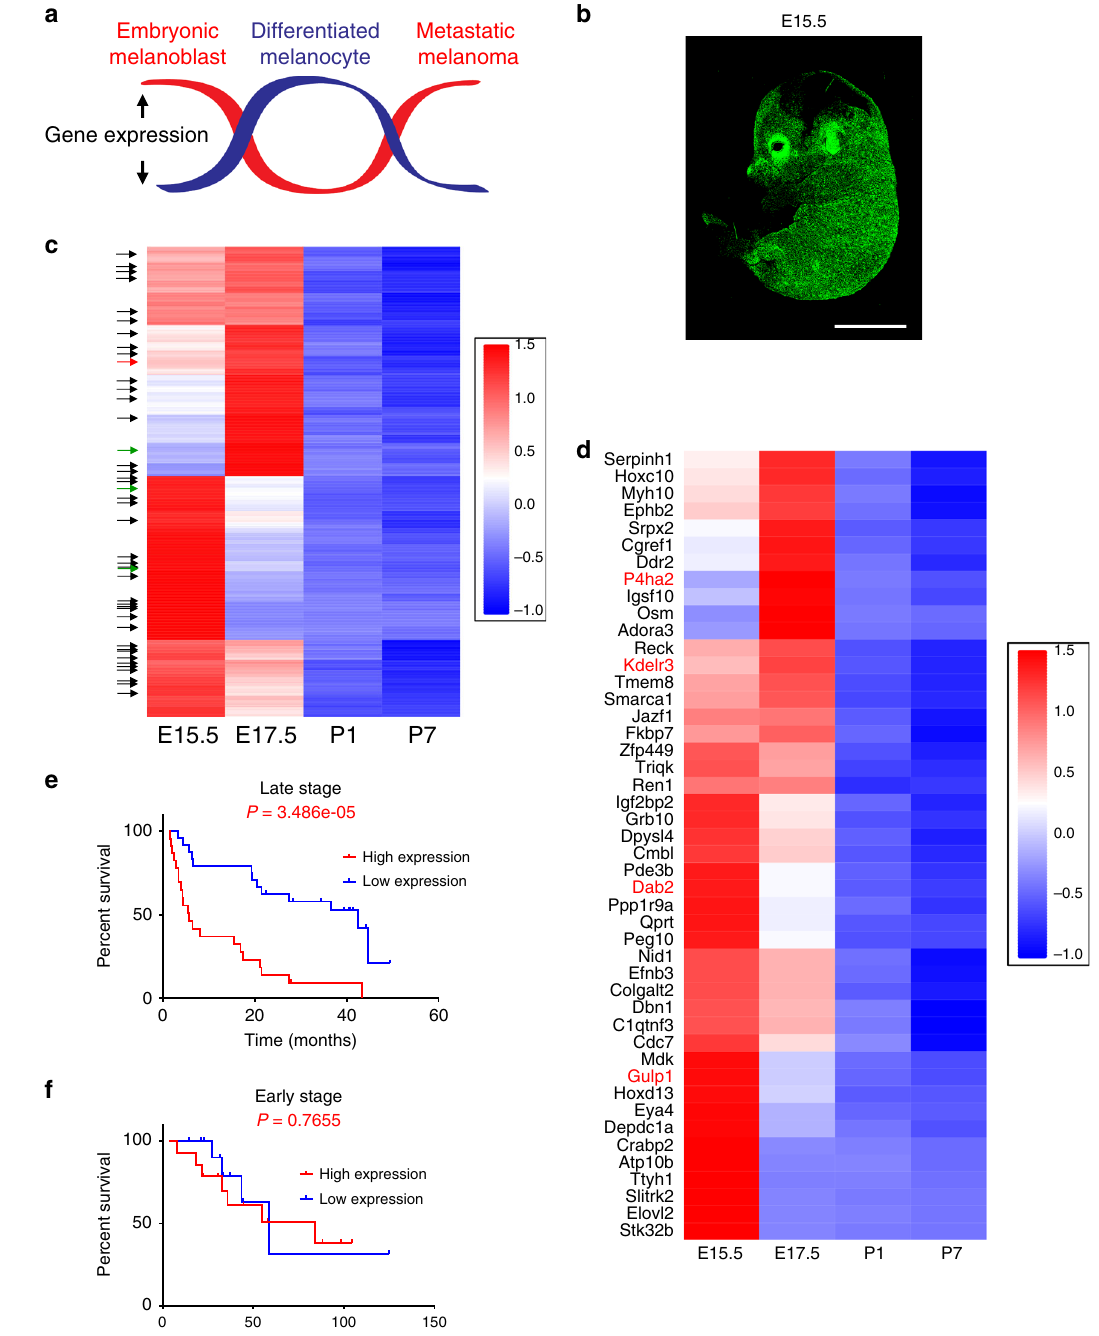
Fig. 1 Discovery of metastasis development (MetDev) genes. a Schematic depicting the experimental hypothesis: genes whose expression is upregulated in melanoblasts and metastatic melanoma, but downregulated in differentiated melanocytes (red line), may drive cellular functions that promote melanoma metastasis (MetDev genes). b Confocal imaging of i Dct-GFP embryo at embryonic day 15.5 (E15.5) is magni fi cation ×5, scale bars, 5 mm. c RNA-seq expression of mouse developing melanocytes: 467 embryo-speci fi c genes shown. Black arrows: 42 genes identi fi ed from Cox proportional hazards model. Green arrows: genes functionally validated. Red arrow: Kdelr3 . Kdelr3 validated both in Cox proportional hazards model and functionally validated. Embryonic days 15.5 and 17.5 (E15.5 and E17.5, respectively). Postnatal day 1 and postnatal day 7 (P1, P7, respectively). d RNA-seq expression of 46 genes in mouse developing melanocytes: Black text: 42 genes identi fi ed from Cox proportional hazards model. Red text: four genes functionally validated. Kdelr3 validated both in Cox proportional hazards model and functionally validated. e , f Cox proportional hazards modeling (GSE19234) yielded a 43-gene MetDev signature. Patients ’ risk assessed in GSE8401 patient cohort. Late stage: stage III/IV metastatic melanomas. Early stage: stage I/II primary tumors. High expression: high expression of gene signature. Low expression: low expression of gene signature. Log-rank test. Late stage, high ( N = 23) vs. low ( N = 24), P = 3.486e − 05. Early stage, high ( N = 14) vs. low ( N = 13), P = 0.7655. c , d Color scales represent gene expression z